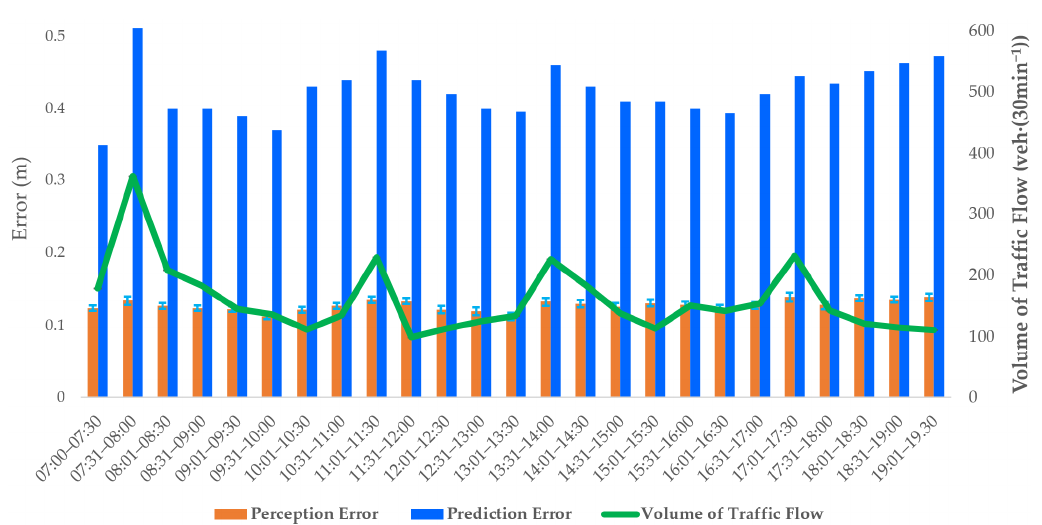
Figure 14. Perception and prediction errors under different traffic